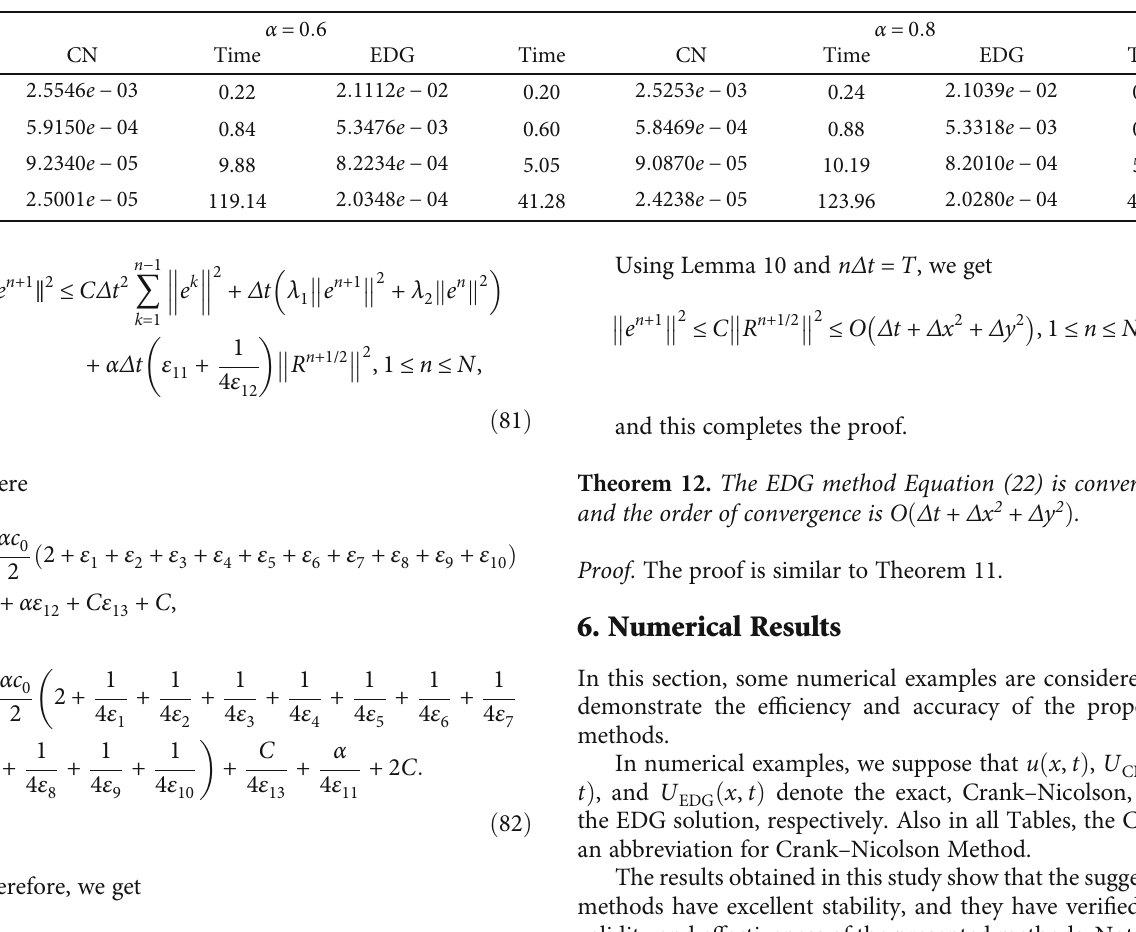
Table 8: Absolute errors of Example 16 at T = 1 for Re = 2 , Δ t = 0 : 01 , α = 0 : 6 , and α = 0 : 8